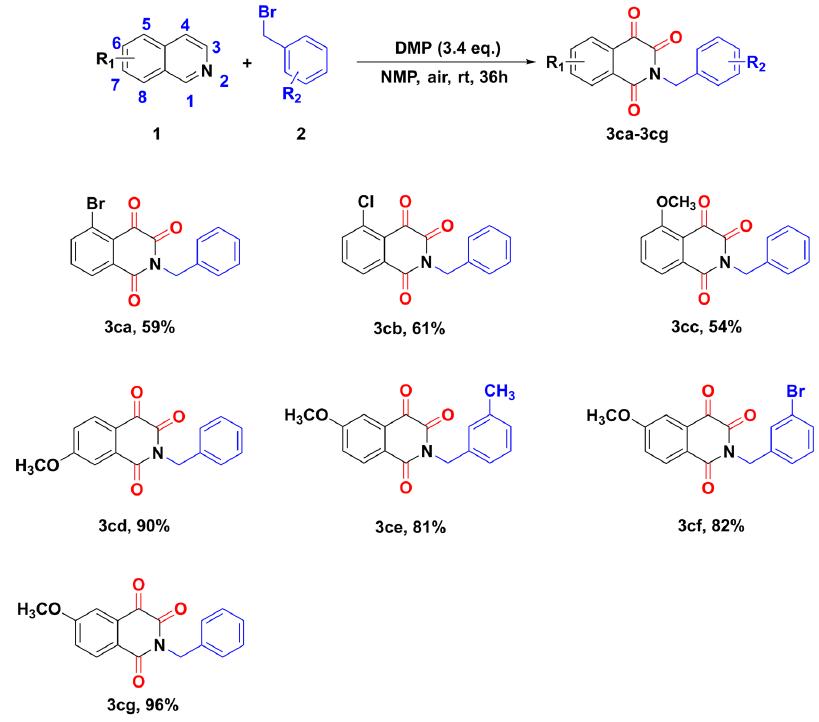
Figure 6. Scope of the synthesis of isoquinoline-1,3,4-triones.